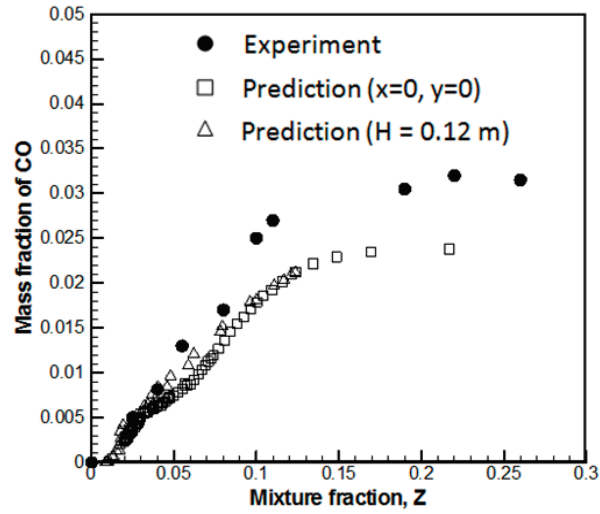
Figure 6. Comparison between the measured and predicted CO mass fraction as a function of the average mixture